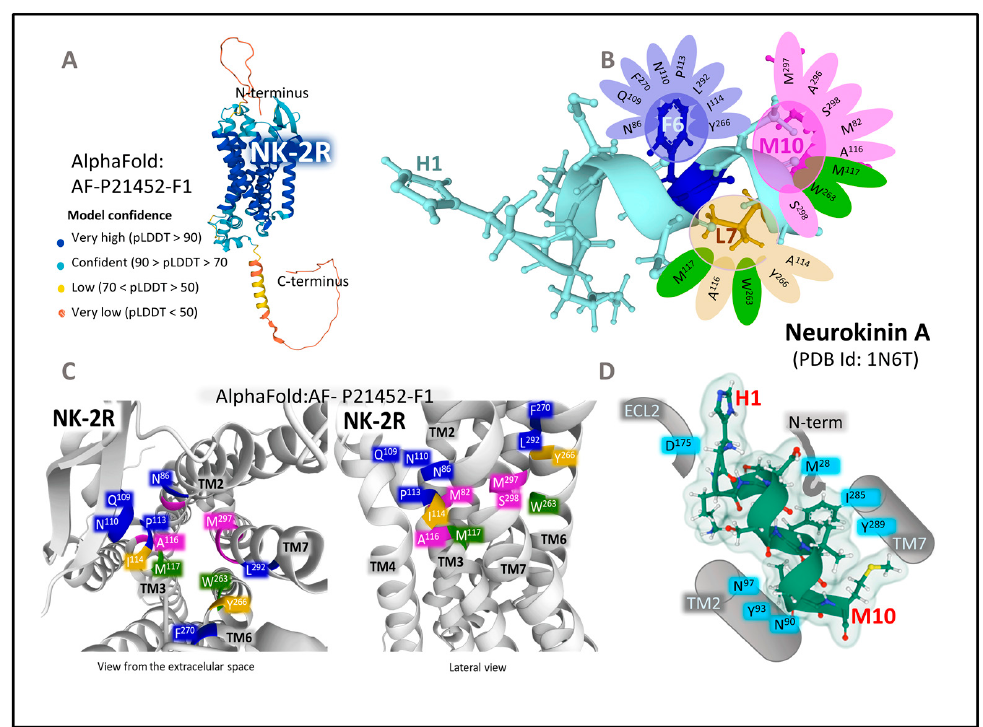
Figure 4. ( A ) represents the predicted structure of NK-2R (UNIPROT P21452) according to the Alpha-Fold prediction [62–64]. The parameter pLDDT (predicted local distance difference test) assessed the model confidence. ( B ) depicts the 3D structure of NKA determined by NMR obtained from the Protein Data Bank [65] (PDB ID 1N6T [55]) drawn with Mol* free web-based software [48]. According to the model, the contacts of NKA’s C-terminal amino acids with the receptors’ amino acids are depicted. ( C ) shows two views of a three-dimensional representation of NK-2R, obtained from modeling and docking studies [56], indicating the situation of principal amino-acid positions in the Alpha-Fold model of NK-2R closely contacting the C-terminal region of NKA. Residues in green contact more than one pharmacophore of NKA. ( D ) represents further contacts of NKA (PDB ID 1N6T, [56]) with NK-2R according to data from the cryo-EM structure provided by Sun et al.